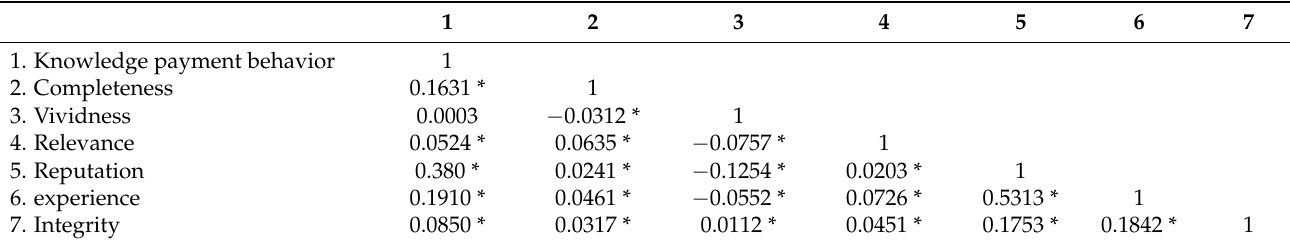
Table 5. Pearson correlation coefficients of key